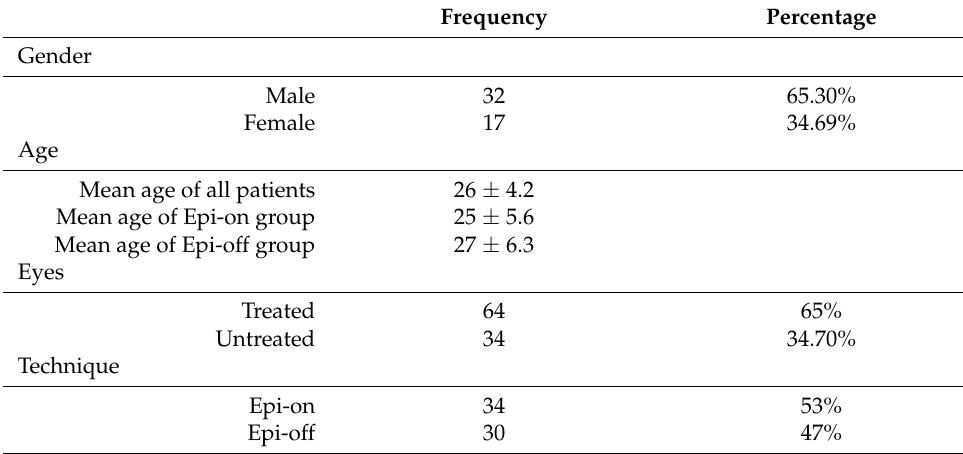
Table 1. Patients’ Demographics.